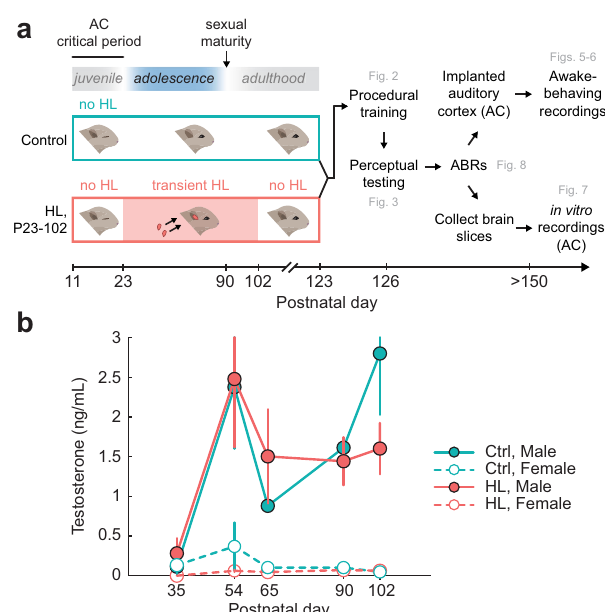
Fig. 1 Transient sensory deprivation during adolescence. a